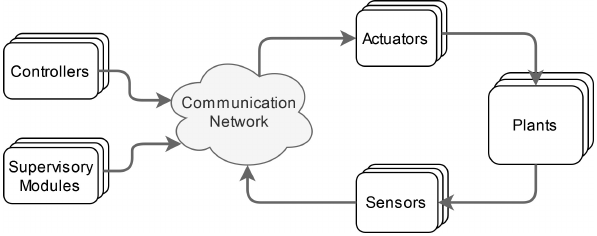
Figure 2. Networked control systems